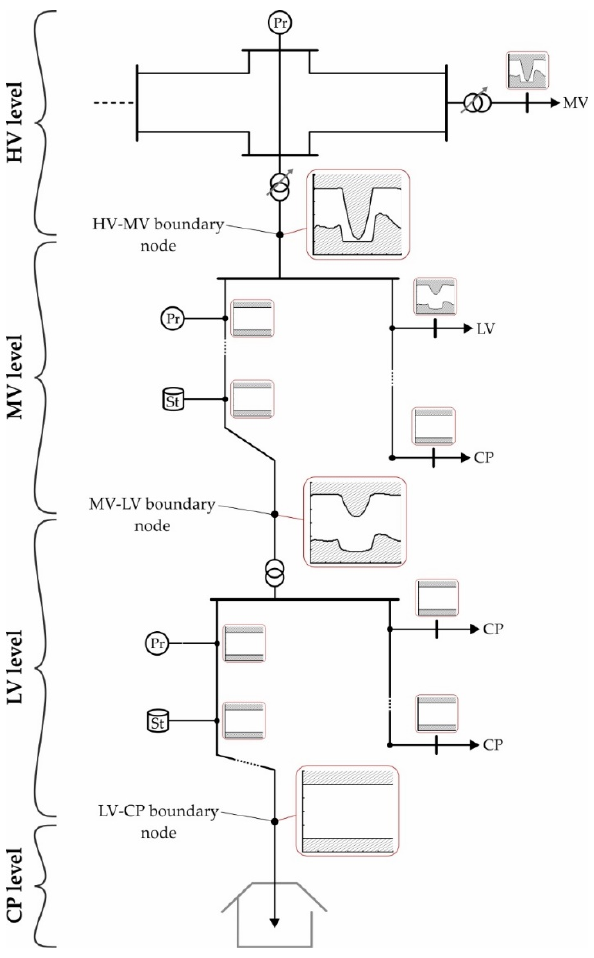
Figure 14. Deformation of voltage limits along the vertical power system axis.